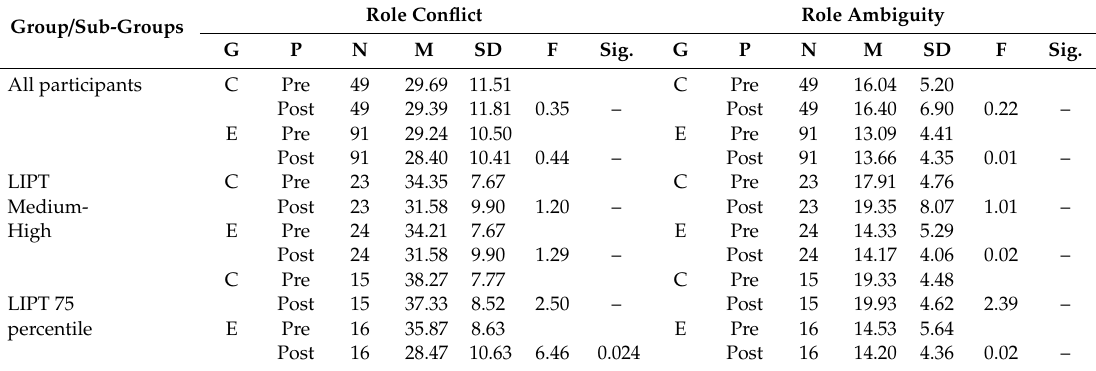
Table 3. Repeated measures analysis. Role conflict and role ambiguity variables before and after the intervention for control and experimental